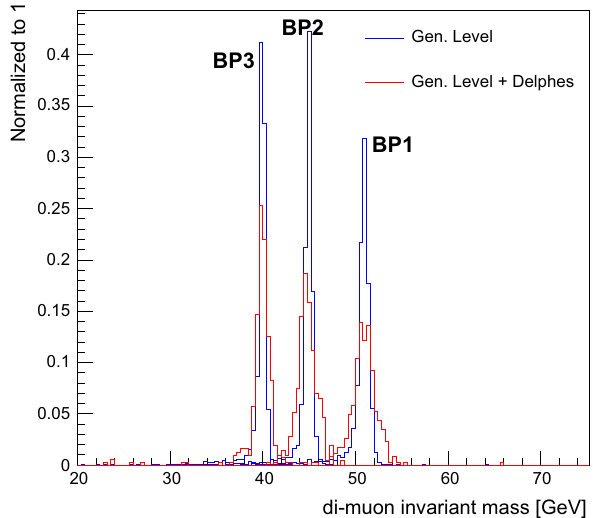
di-muon invariant mass [GeV] Fig. 12 The distribution of di-lepton pair invariant mass in signal ( (cid:2)(cid:2)(cid:2)ν H H ) with and without detector simulation (CMS) using